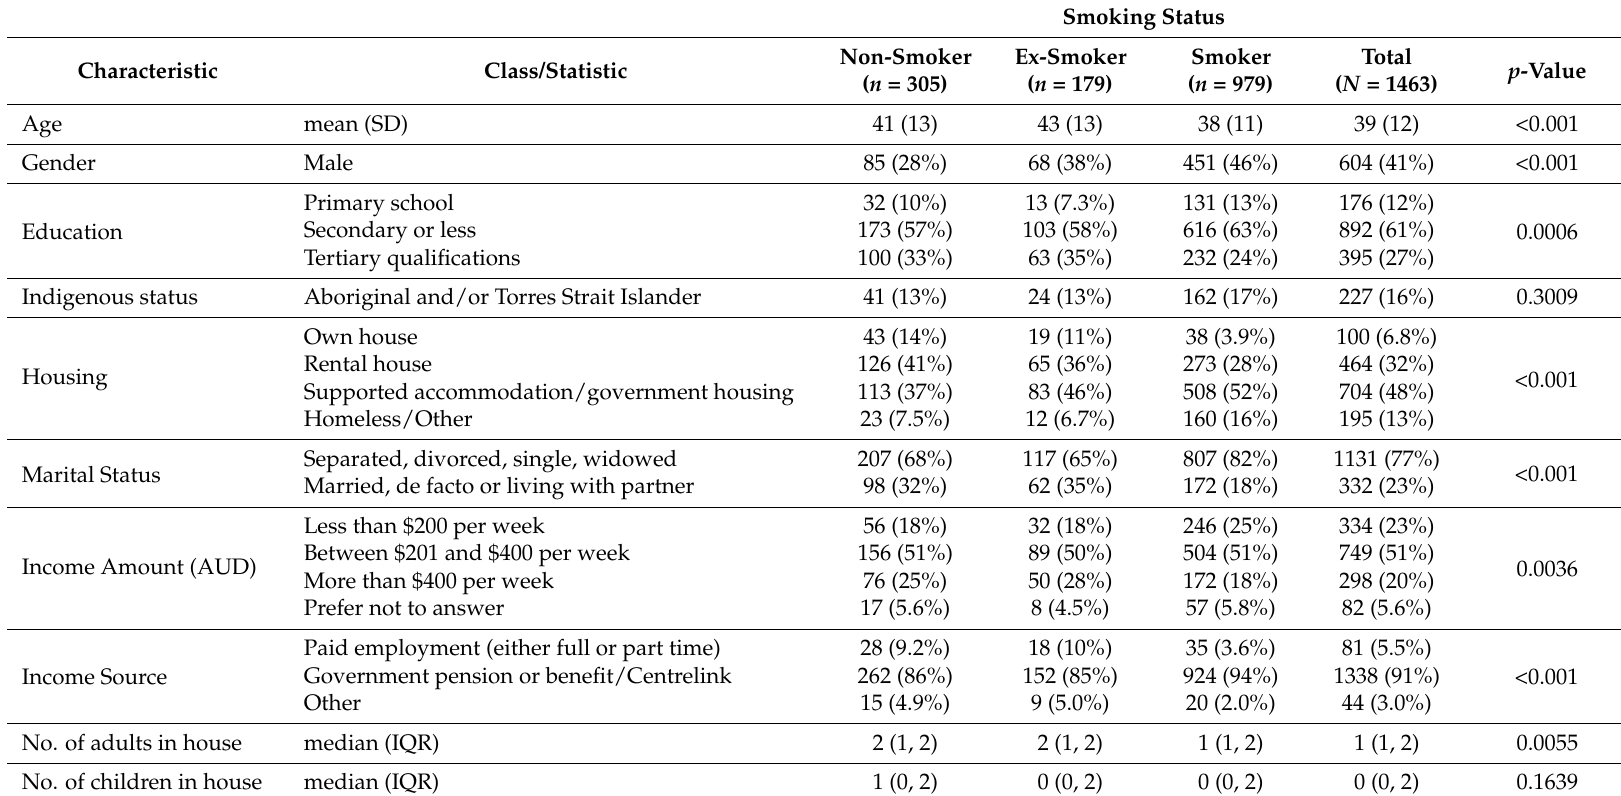
Table 1. Demographic and smoking characteristics of the study sample ( N =